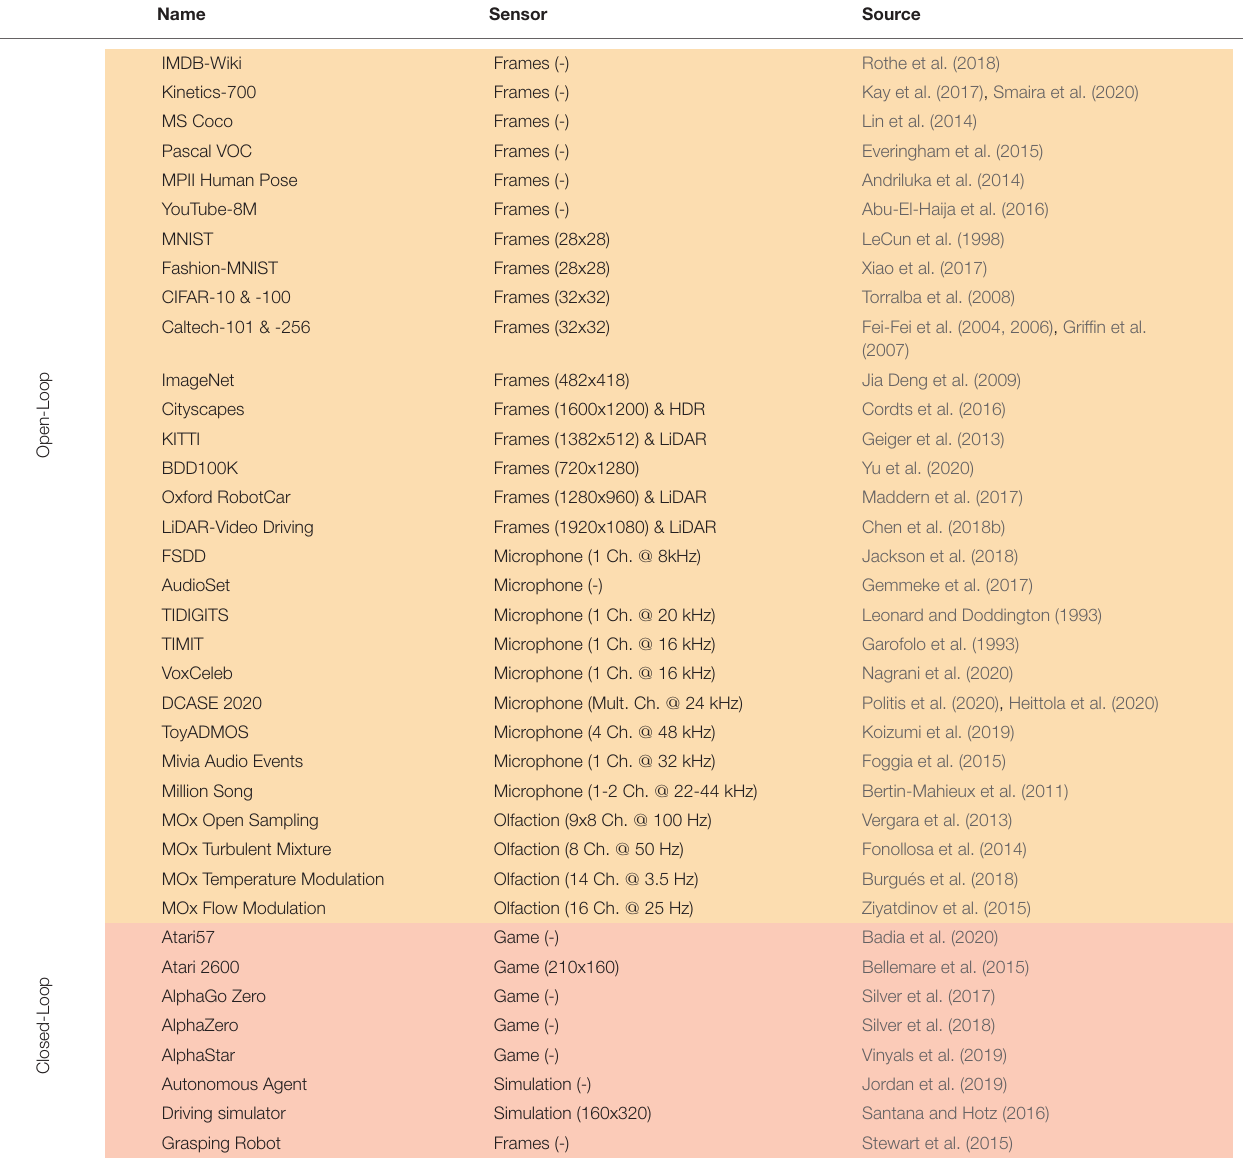
TABLE 1 | Conventional Benchmark Datasets for various sensor